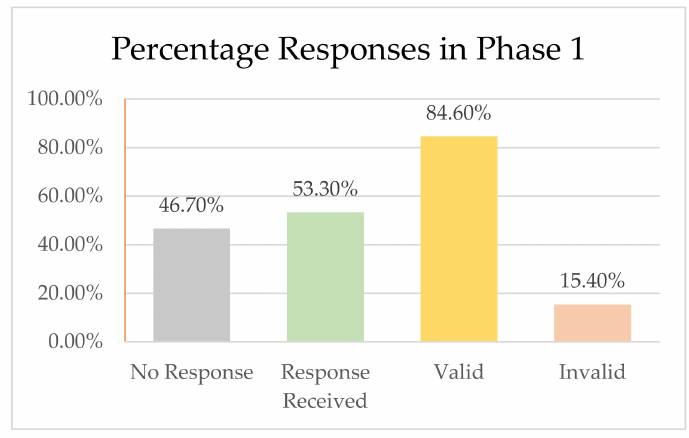
Figure 4. Percentage of total questionnaires sent and their